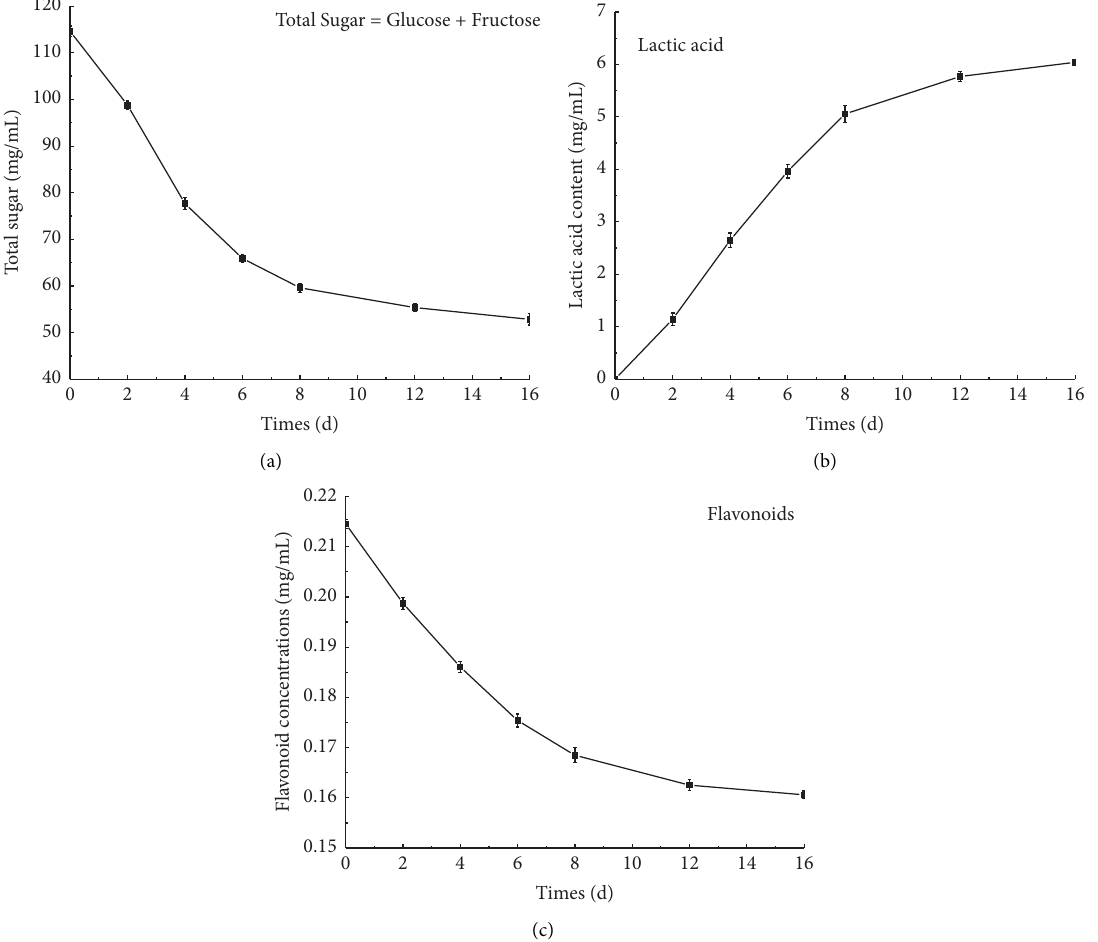
Figure 4: (a) Te change of glucose and fructose content in fermentation process; (b) the change of lactic acid content in fermentation process; (c) the change of favonoids in the fermentation